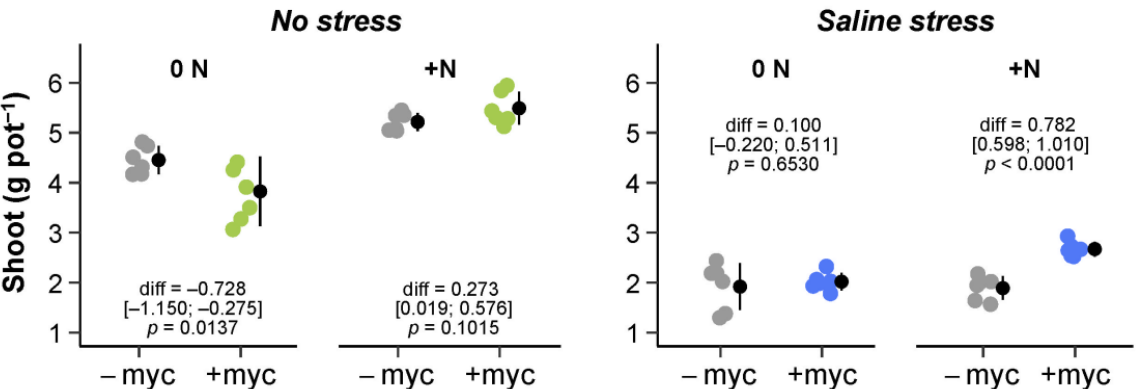
Figure 2. Shoot dry weight (g per pot) of durum wheat to varying treatments: no-stress or saline stress condition; N fertilization treatments (0 N, +N); absence or presence of arbuscular mycorrhizal fungal inoculum ( − myc, +myc). Black circles represent means, with whiskers representing ± SE ( n = 6). Differences (diff) between +myc and − myc means within the same fertilization treatment and the same saline treatment, estimated 95% confidence intervals of mean difference (in brackets), and p values are reported inside the plots.